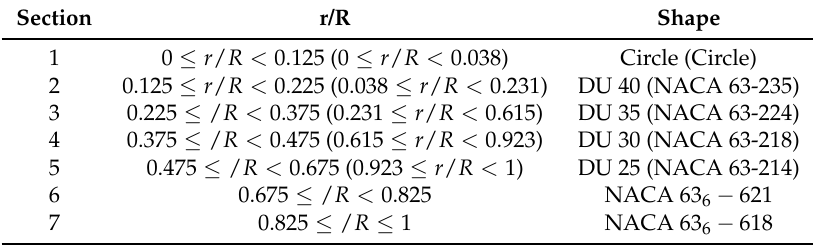
Table 1. Distribution of airfoil shapes along the radial direction [30]. The information in parentheses shows the airfoil shape distribution of the SWiFT turbine